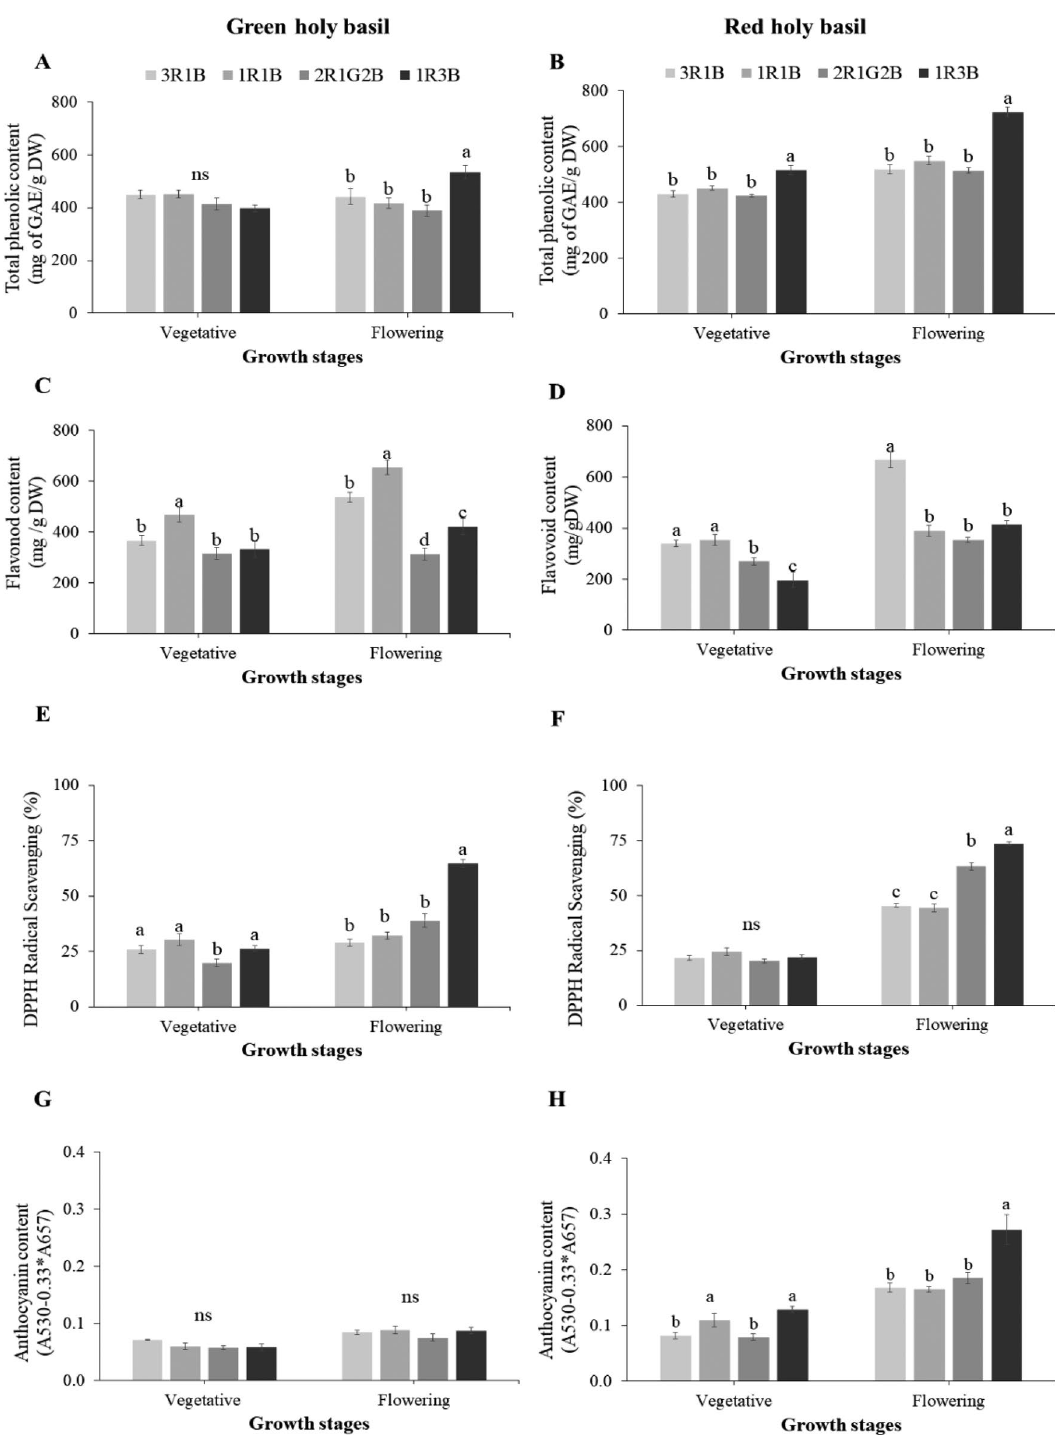
Figure 6. The content of total phenolic content (TPC), flavonoid content, DPPH radical scavenging, and anthocyanin content of green and red holy basil at vegetative and flowering stages under four different light treatments ( 3R:1B, 1R:1B, 2R:1G:2B, and 1R:3B ) . R, G and B represent the red, green and blue llight spectra, respectively, and number before the letters stand for the ratio of each lighrt spectra. Values are represented as mean ± SE (n = 4). ANOVA was performed followed by mean comparison with DMRT. Lower-case letters above bars indicate significant differences (p < 0.05); “ns” indicates no significant difference. Bars indicate standard